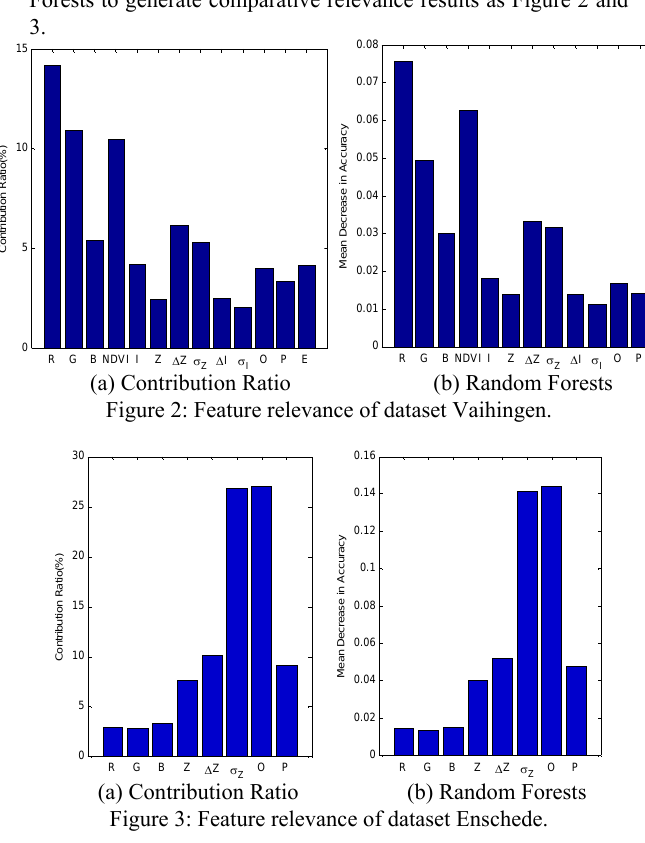
Figure 2: Feature relevance of dataset Vaihingen.